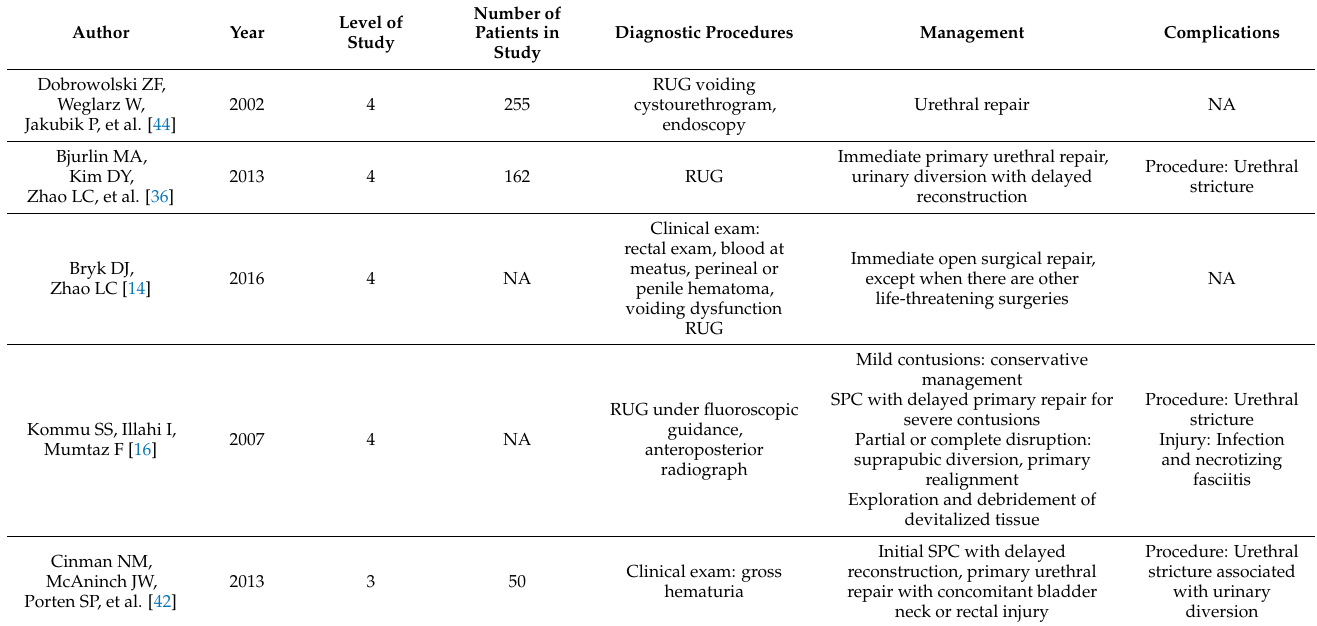
Table 2. Penetrating Anterior Urethral